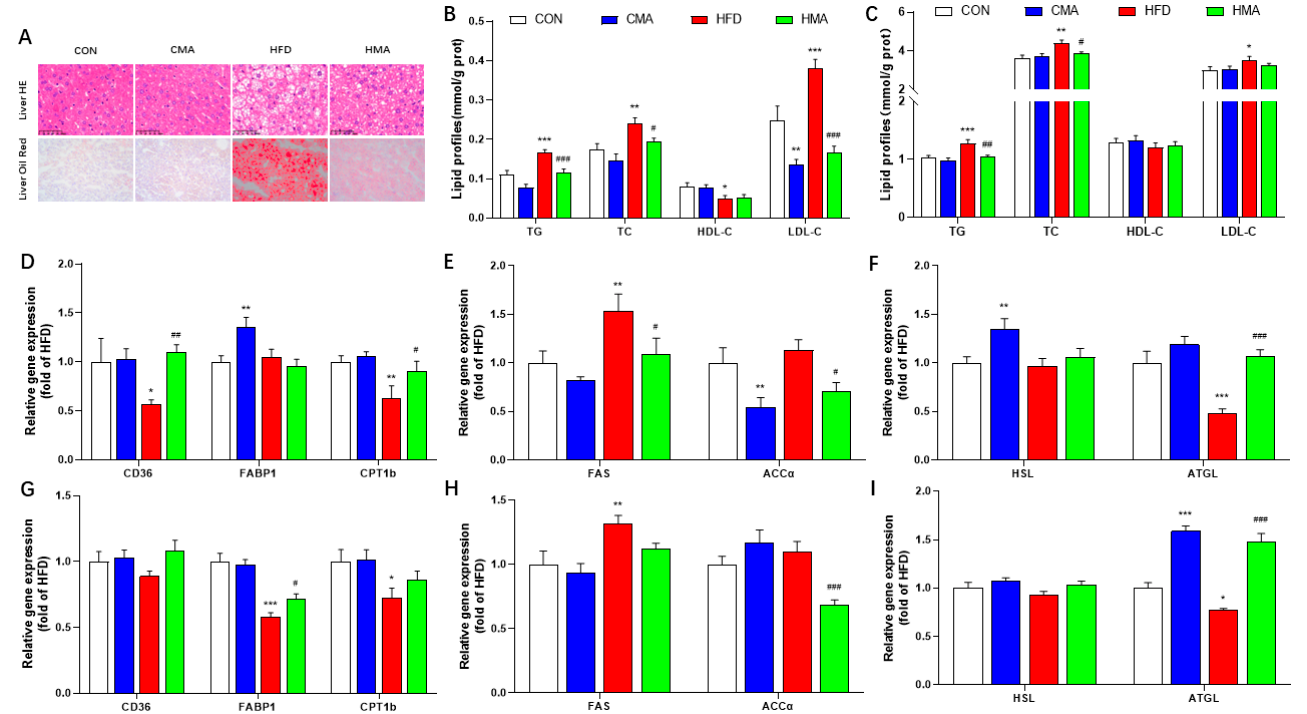
Figure 4. Effect of MA on HFD-induced liver structural damage, and contents of TG, TC, HDL-C, LDL-C, gene expression of lipid transport (CD36 and FABP1), lipases (ATGL and HSL), β -oxidation (CPT1b) and synthesis (FAS and Acc α ) in the liver and EAT of mice. ( A ) HE staining of liver and EAT (400×). ( B ) Contents of TG, TC, HDL-C and LDL-C in liver tissue. ( C ) Contents of TG, TC, HDL-C and LDL-C in EAT. ( D ) Fatty acid transport and β -oxidation in liver tissue. ( E ) De novo fat synthesis in liver tissue. ( F ) Fat metabolism enzymes in liver tissue. ( G ) Fatty acid transport and β -oxidation in EAT. ( H ) De novo fat synthesis in EAT. ( I ) Fat metabolism enzymes in EAT. The values are expressed as mean ± SEM (n = 10). Differences between the CON group and the CMA and HFD groups are indicated by *. *** p < 0.001, ** p < 0.01, * p < 0.05. Differences between the HFD group and the HMA group are expressed by # . ### p < 0.001, ## p < 0.01, and # p < 0.05.